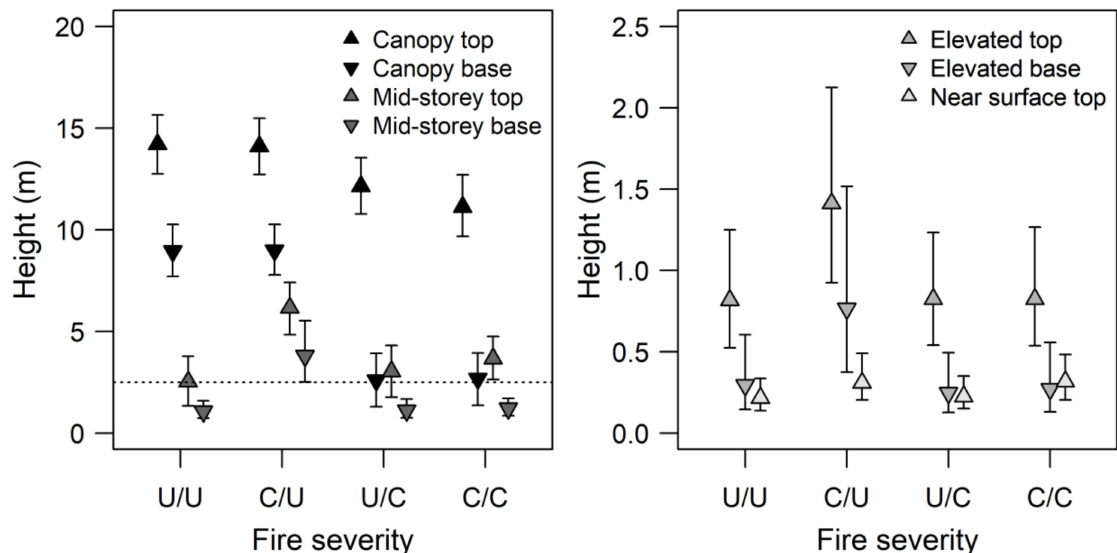
Figure 4. Model predictions for the plant crown top and base heights across the four fuel strata. The left panel shows the canopy and mid-storey layers. The right panel shows the elevated and near-surface layers. Upward-facing triangles represent the average crown top height and downward-facing triangles represent the average crown base height. Error bars show the 95% confidence intervals. The broken line in the left panel corresponds to the maximum height (2.5 m) in the right panel. The fire severity combinations are understorey fire followed by an understorey fire (U/U), canopy fire then an understorey fire (C/U), understorey fire then a canopy fire (U/C) and canopy fire then a canopy fire (C/C). The surface fine-fuel load was affected by SEV13 but not SEV07 (Table 1). The